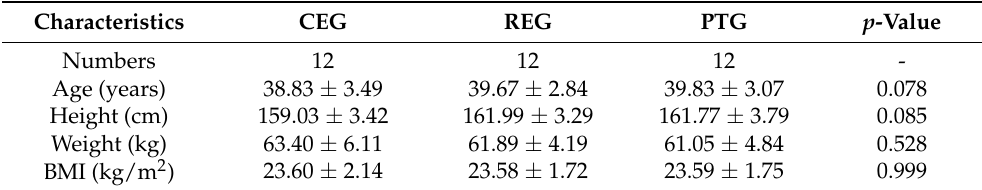
Table 3. Baseline characteristics of